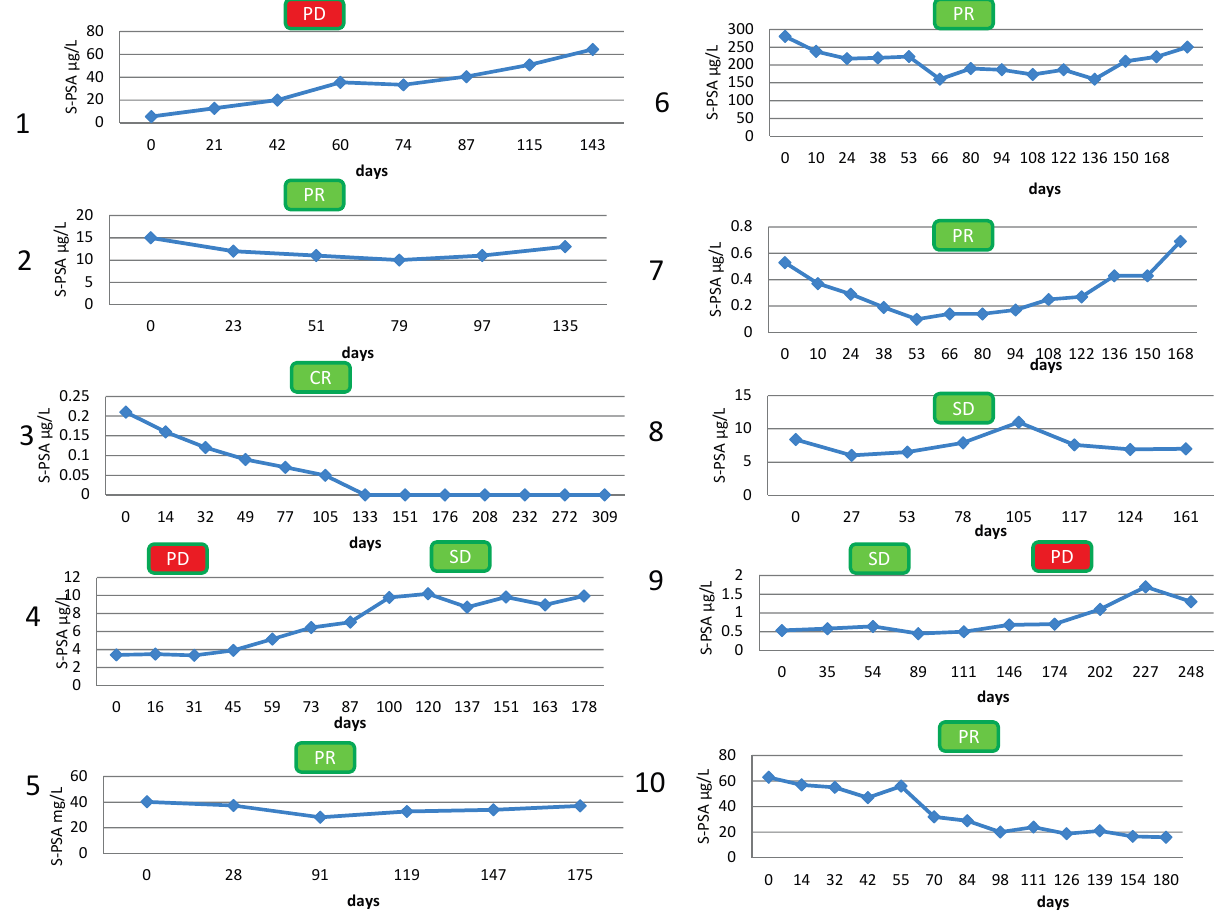
Figure 1. PSA-curves before, during 6 cycles, and 1 month after Ra-223 treatments in all patients; response, if >25% decrease in S-PSA values. SD = stable disease, PR = partial response (>25% decrease), CR = complete response (>75% decrease), PD = progressive disease (>25% increase). The number refers to patient number (Tables 1 and 2), y-axis S-PSA concentration in μ g/L, x-axis time in days, starting from the day of 1st Ra-223 treatment. Numbers 1–10 refer to patient number in Tables